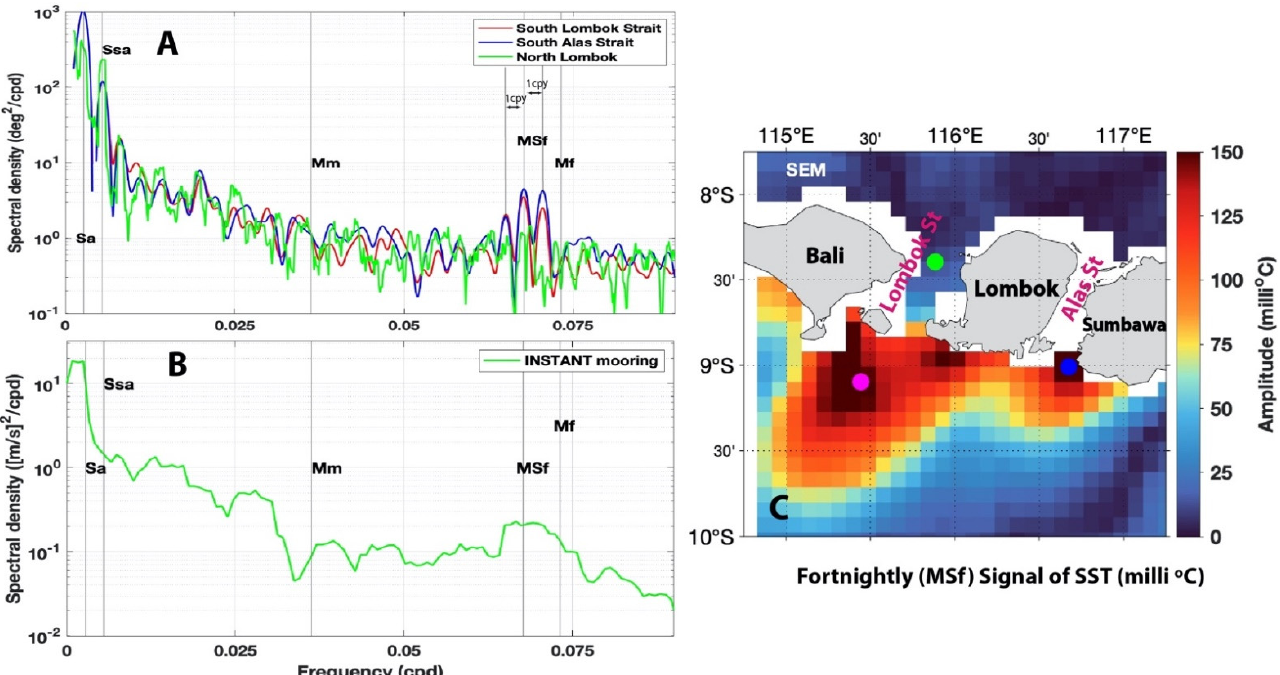
Figure 6. ( A ) SST spectrum based on 20 years of daily GHRSST data south of Lombok and Alas Straits (red and blue curves), and at the location of the INSTANT mooring at the northern end of Lombok Strait (green curve). Note that the strong MSf peaks in the red and blue curves are accompanied by two side-peaks, which are precisely one cycle-per-year (cpy) from the central MSf peaks [21], thus indicating substantial annual modulation, which Figure 3 explicitly shows; ( B ) Velocity spectrum of the INSTANT time series. Labeled vertical dashed lines mark frequencies Mf (T = 13.66-days); MSf (T = 14.77-days), and Mm (T = 27.55-days); the two lines at the far left mark annual and semiannual frequencies (Sa and Ssa); ( C ) Estimates of fortnightly (MSf) SST amplitude in milli °C (zoom in Figure 3A). Locations of observations for the spectrum analysis (red, green, and blue curves).